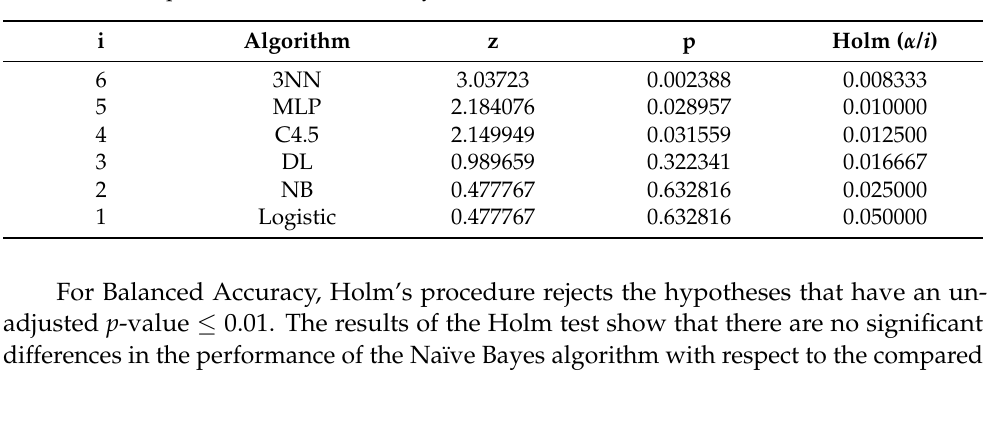
Balanced Accuracy Ranking